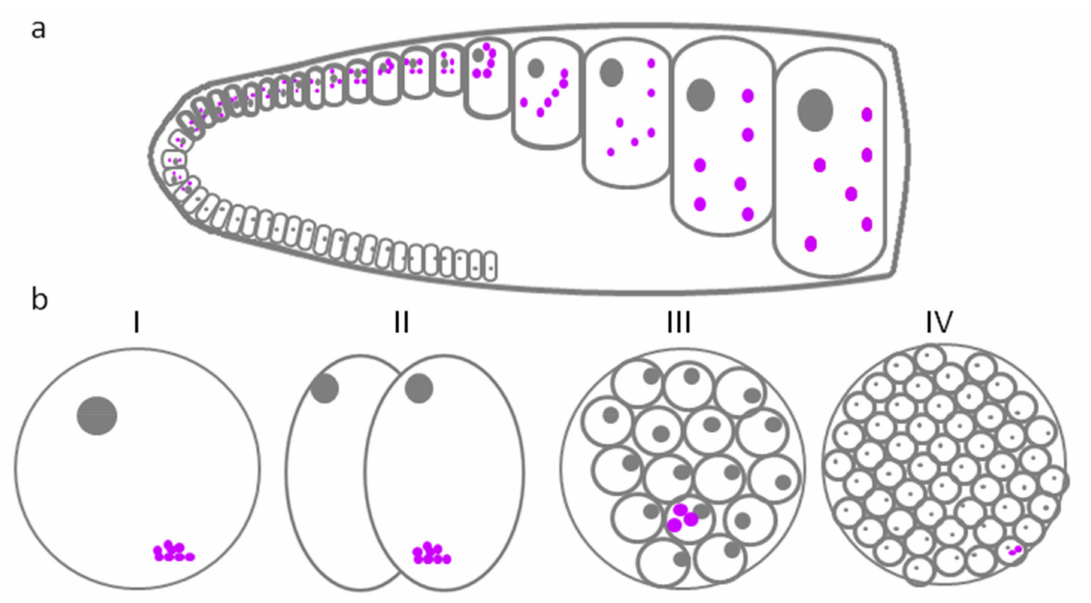
Figure 1. P-granules of C. elegans . ( a ) Schematic diagram of a longitudinal section through one arm of an adult hermaphrodite gonad. The drawing represents the P-granules localization at different stages of oogenesis. Spermatogenesis is not shown. ( b ) Localization of P-granules at the early stages of embryogenesis (I-zygote, II-2-cells embryo, III-16-cells embryo, and IV-in an embryo with formed germline cells (Z2 and Z3)). Cells are outlined with grey, and nuclei are shown as closed grey circles. P-granules—closed purple